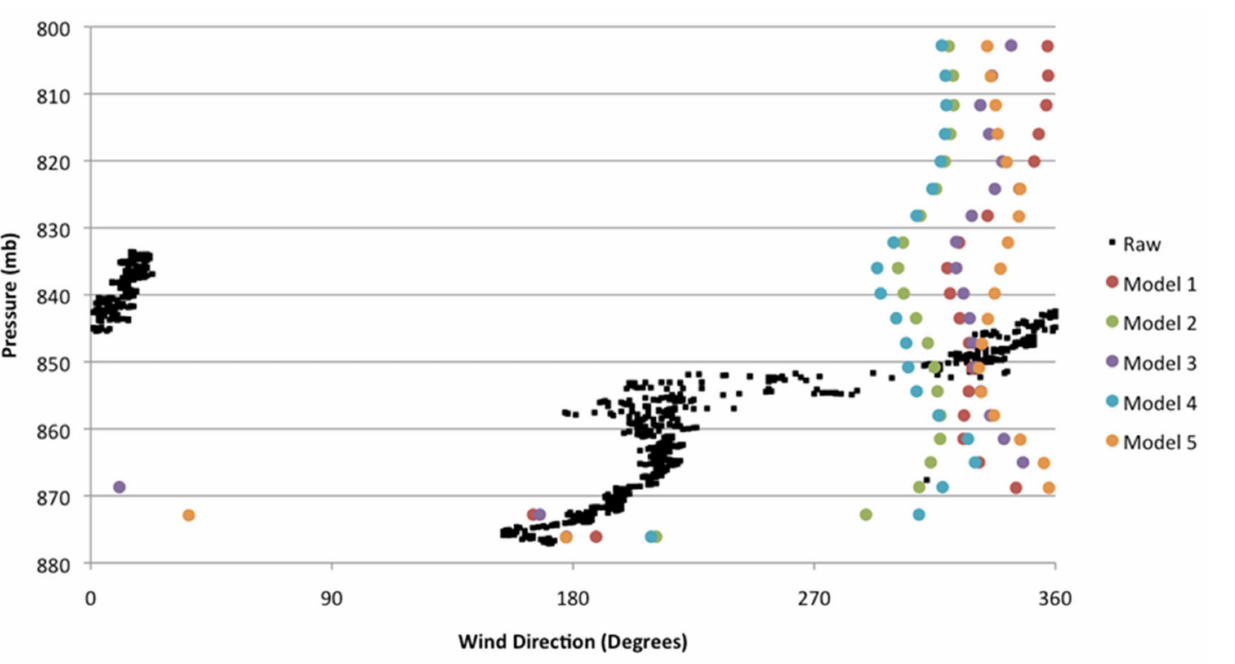
Figure 22. Model upper-air wind direction profile ( ◦ ) shown by pressure level (hPa) for different model experiments vs. tethersonde at 1300 UTC 10-14-2012 at the Sagebrush (off-playa)